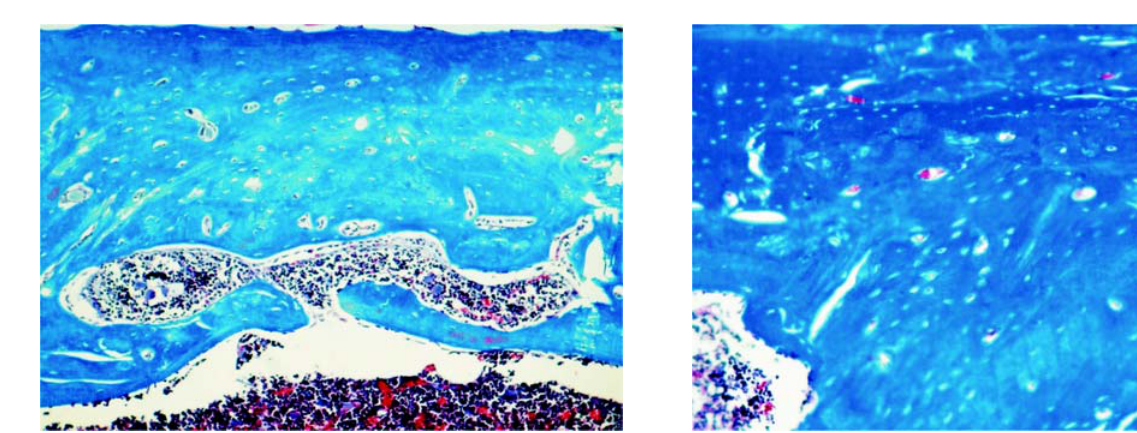
FIGURE 4- Group CG30: Total closing of the defect by well formed bone. Bone graft is totally incorporated to the newly formed bone area. Masson’s Trichrome (Original